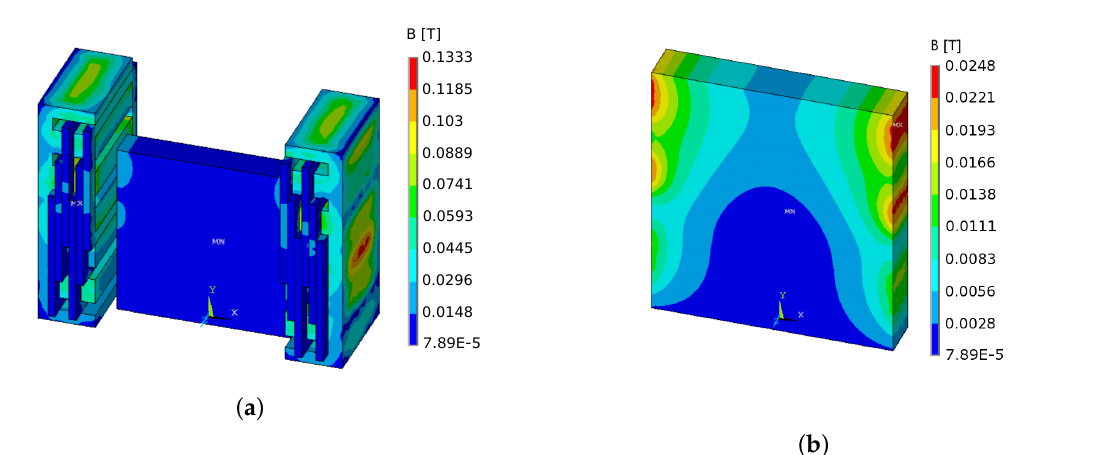
Figure 4. Magnetic flux density on surfaces of whole TMF stirrer ( a ) and melt volume ( b